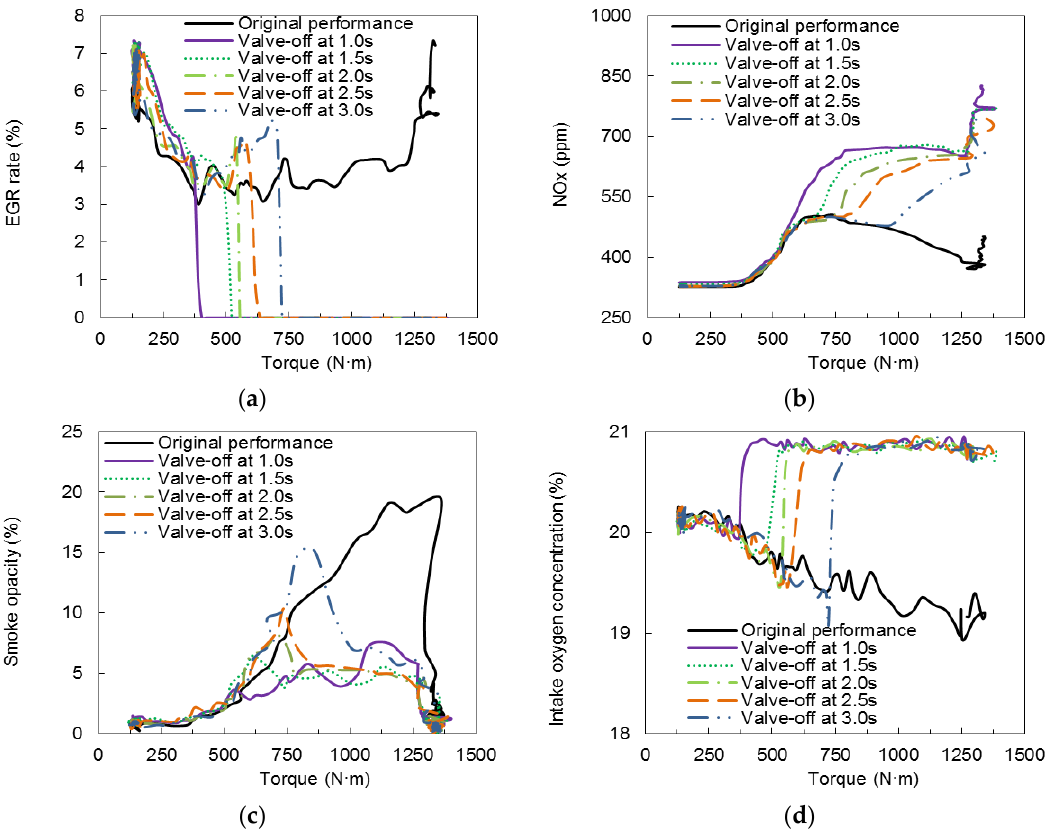
Figure 5. Effect of different EGR valve-off time on diesel transient performance: ( a ) EGR rate; ( b ) NOx; Figure 5. E ff ect of di ff erent EGR valve-o ff time on diesel transient performance: ( a ) EGR rate; ( b ) NOx; ( c ) Smoke opacity; ( d ) Intake oxygen concentration. ( c ) Smoke opacity; ( d ) Intake oxygen